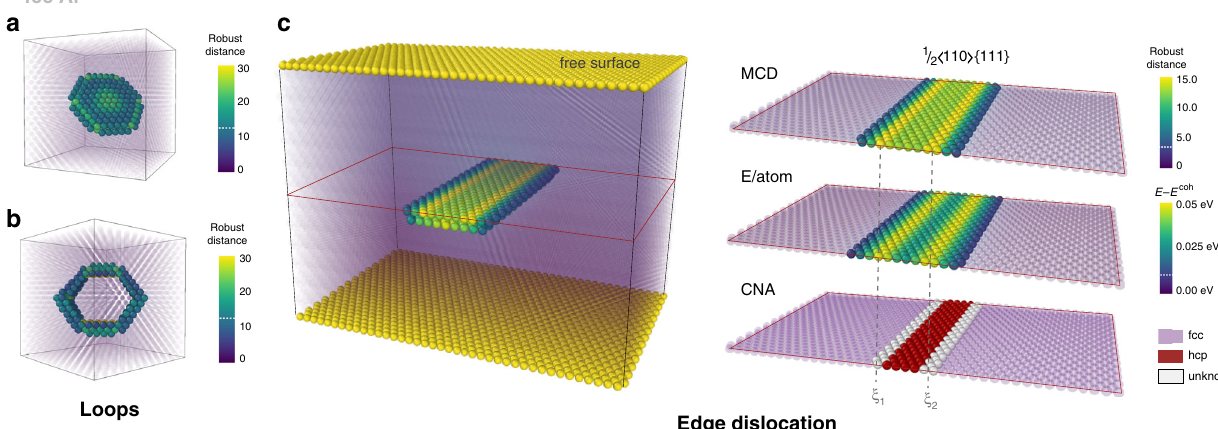
h 111 if 111 g ; b 1 h 110 if 111 g loop; c 1 h 110 i dissociated edge dislocation. 3 2 2 and ξ . 1 2